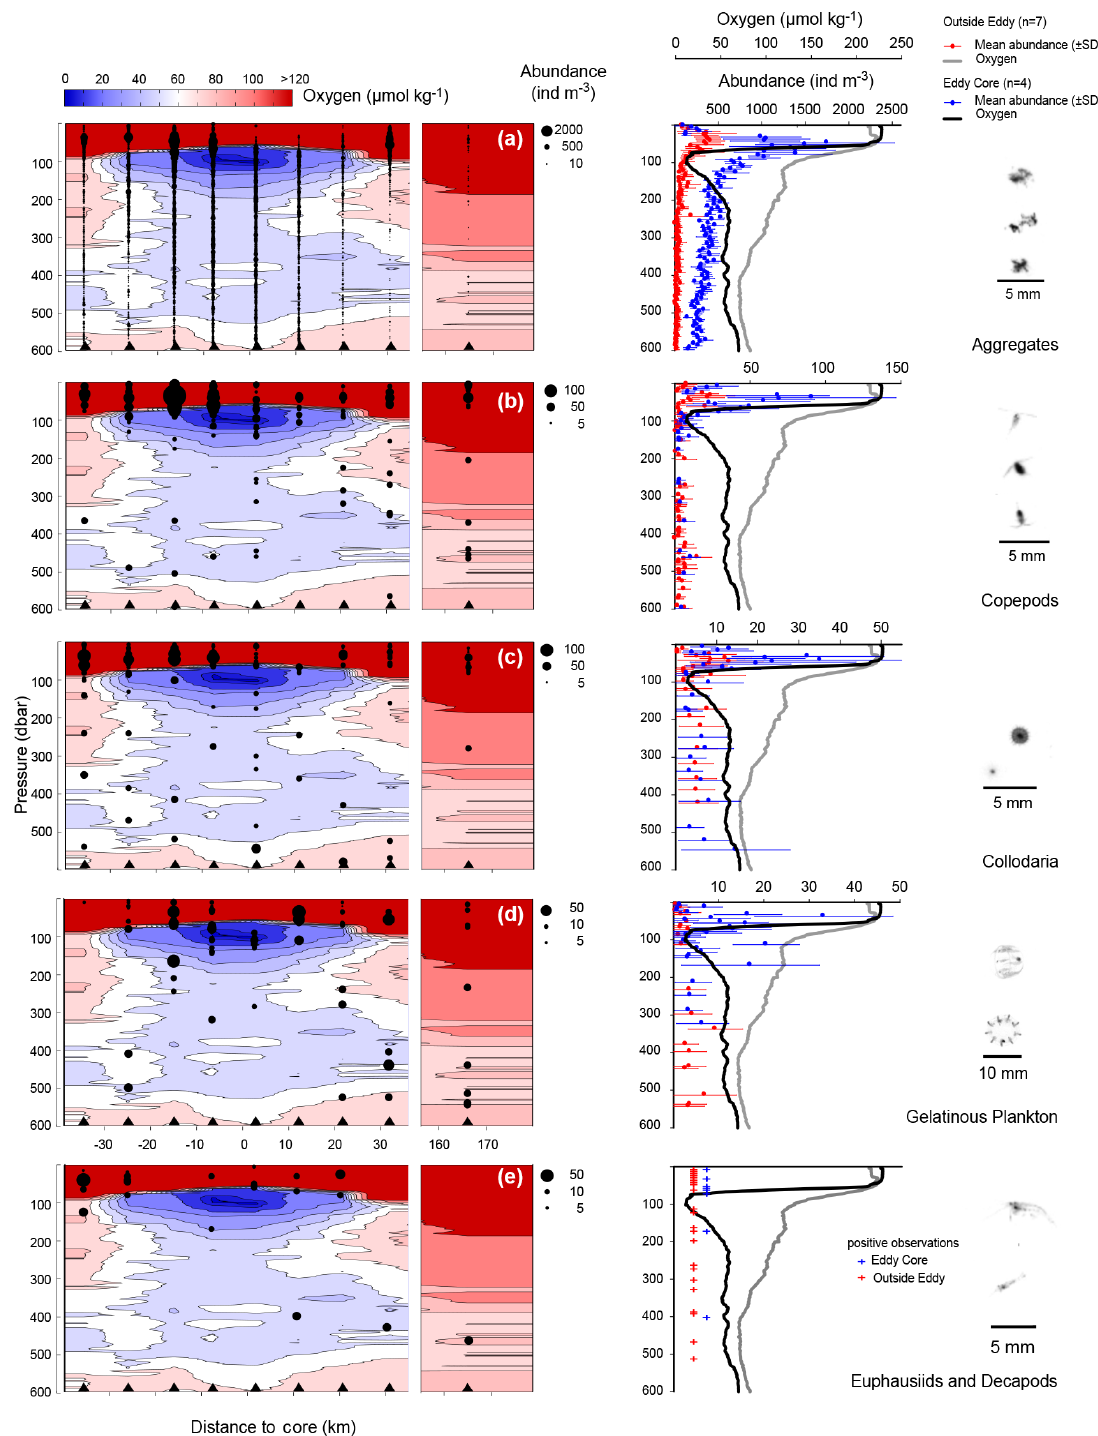
Figure 4. Left column shows oxygen contours (µmolO 2 kg − 1 ) across the eddy (from NE to SW) with superimposed bubble plots of UVP- based abundance (individualsm − 3 , in 5m depth bins) of aggregates (a) , copepods (b) , collodaria (c) , gelatinous plankton (d) and shrimp-like organisms (euphausiids and decapods) (e) . Note break in distance axis on section panels. Triangles denote CTD/UVP stations. Middle column are profiles of mean ( ± SD) abundance within the eddy core ( n = 4) and at the CVOO station ( n = 7) along with mean oxygen profiles with the exception of euphausiids and decapods (e) , where “ + ” denotes positive observations. For better visibility at low values, data with mean abundance = 0 are omitted. Right column shows representative images of the respective